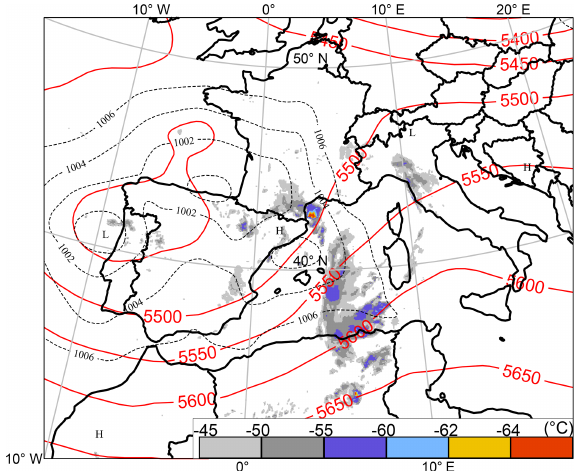
Figure 1. ARPEGE analysis for IOP16a in terms of 500hPa geopo- tential height (solid line, every 50 dam) and mean sea level pressure (dashed line, hPa) and Meteosat Second Generation infrared bright- ness temperature ( ◦ C) (channel 9, 10.8µm) (coloured areas) valid at 06:00UTC on 26 October 2012.